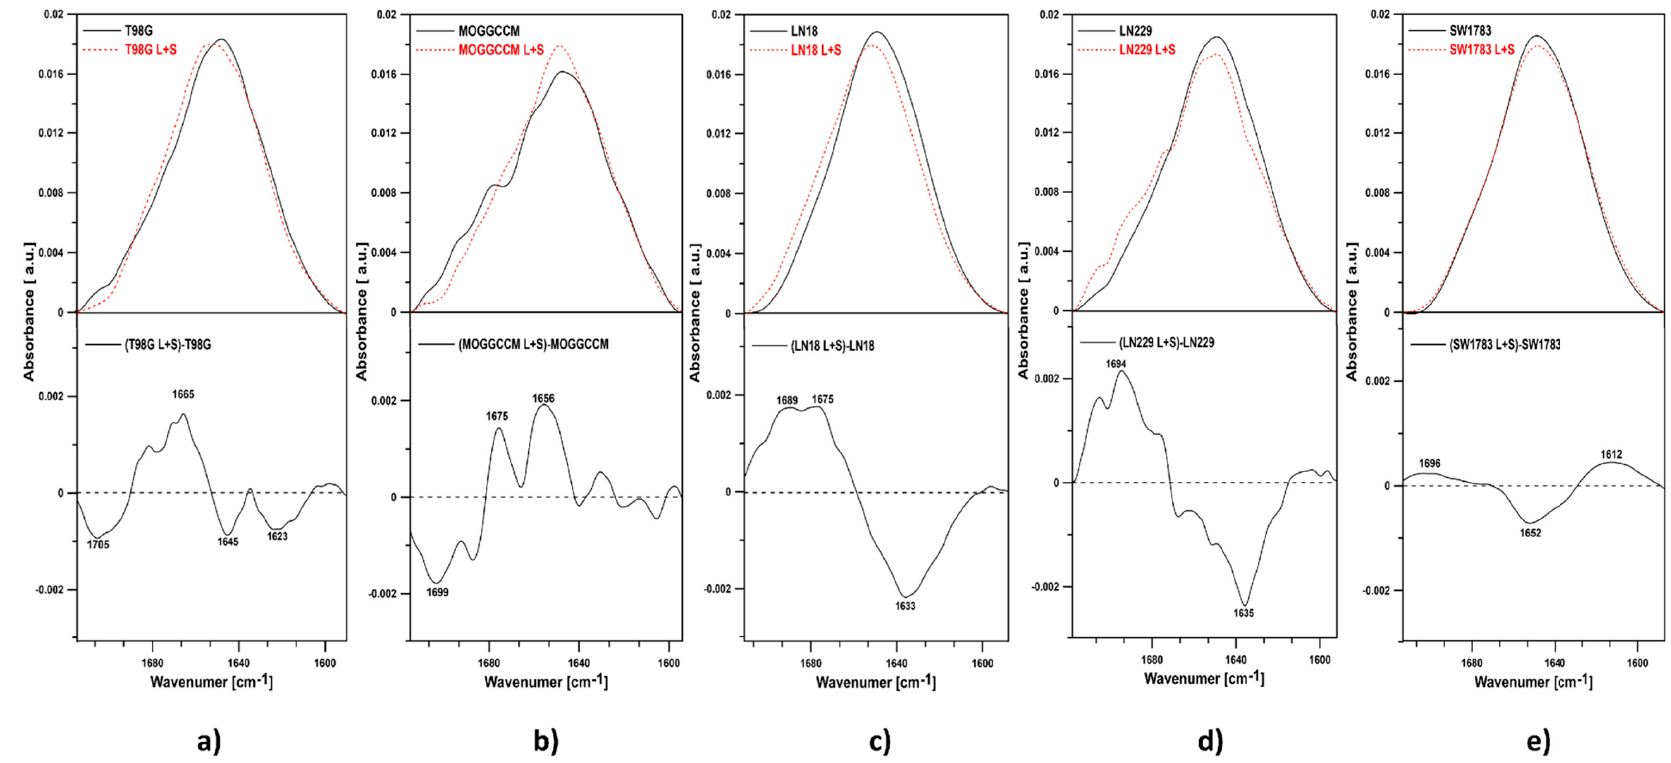
Figure 12. ATR-FTIR spectra of the amide I region (1700–1600 cm − 1 ) of the control cells (upper panel, solid black line), of the cells incubated with lensoside A β and sorafenib for 24 h (upper panel, red, dashed line), and the differential spectra (lower panel) from ( a ) T98G, ( b ) MOGGCCM, ( c ) LN-18, ( d ) LN229, and ( e )